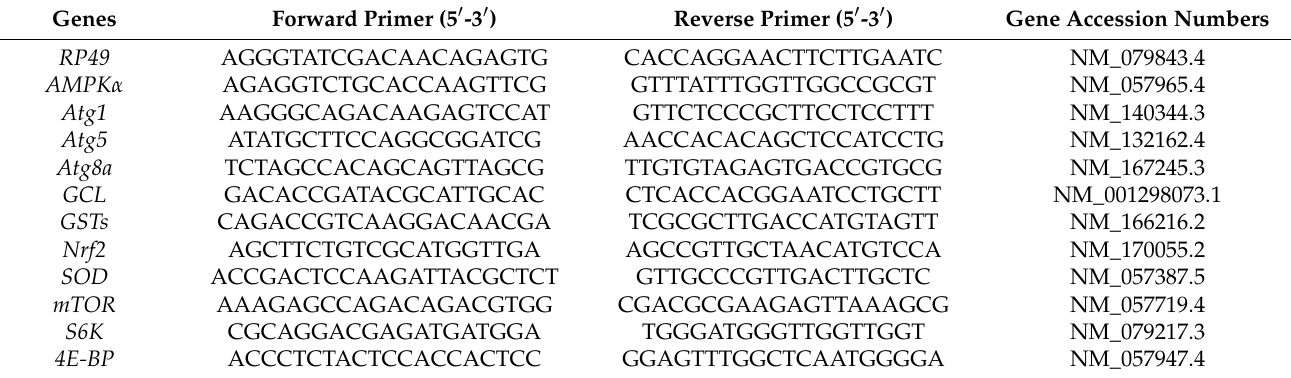
Table 1. Primers used in this